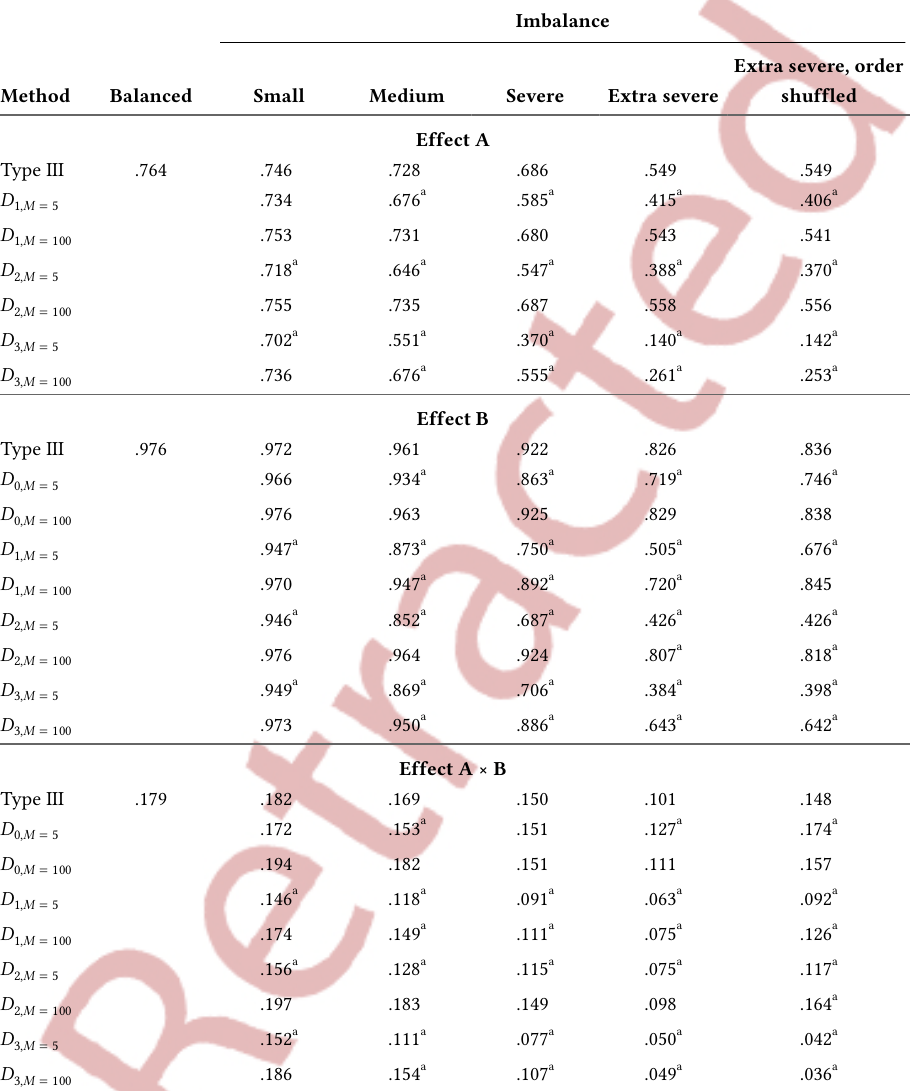
Rejection Rates for Each Effects Under the Alternative Model, a Small Sample Size, Three Levels of Factor B, for Different Methods for Handling Imbalance, and Different Degrees of